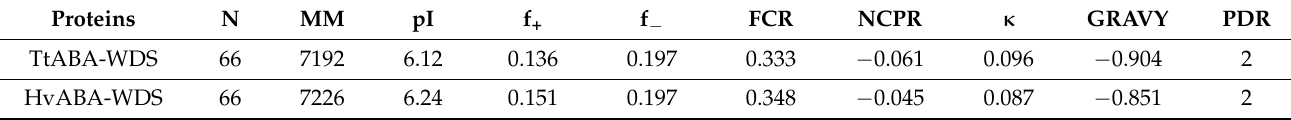
Figure 1. ( A ) Amino acid sequence alignment of TtABA-WDS and HvABA-WDS. Basic residues are in blue, acidic residues in red, prolines in pink, histidines in green and aromatic residues in orange. Amino acid substitutions are shown in bold on a yellow background. The alignment was generated with Clustal Omega and then edited manually. ( B ) Deviation in amino acid composition from the Swiss-PROT database of TtABA-WDS and HvABA-WDS. The relative enrichment in disorder promoting (pink and green bars) and depletion in order-promoting (grey bars) residues is shown. Residues have been ordered on the x -axis according to the TOP-IDP flexibility index as described in [28]. Table 1. Properties of the deduced amino acid sequences of the TtABA-WDS and HvABA-WDS domains.